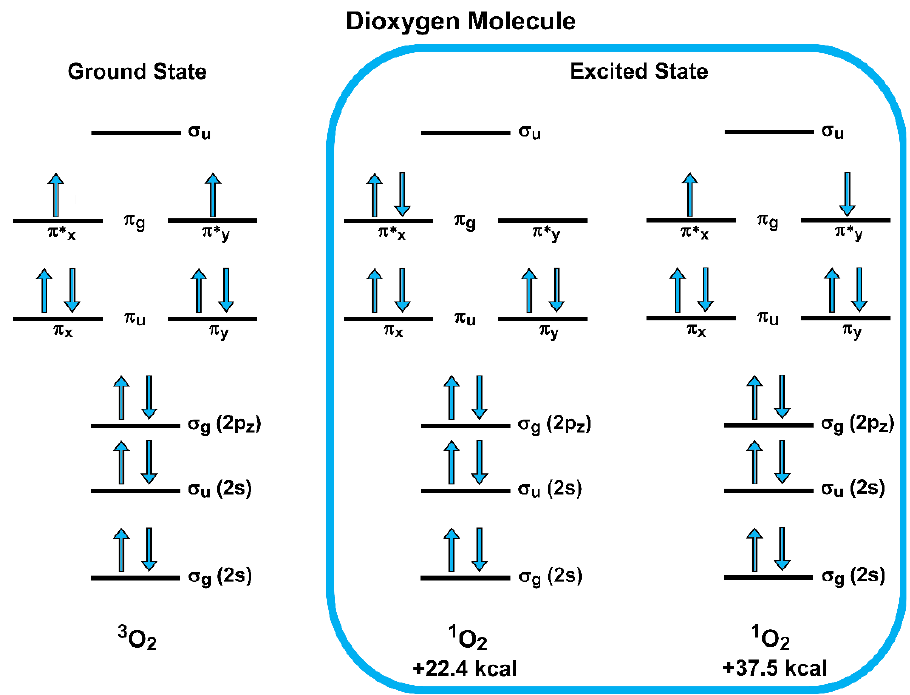
Figure 8. Electronic configurations energy levels of the ground state 3 O 2 (triplet oxygen) and excited state 1 O 2 (singlet oxygen) of O 2 molecule.